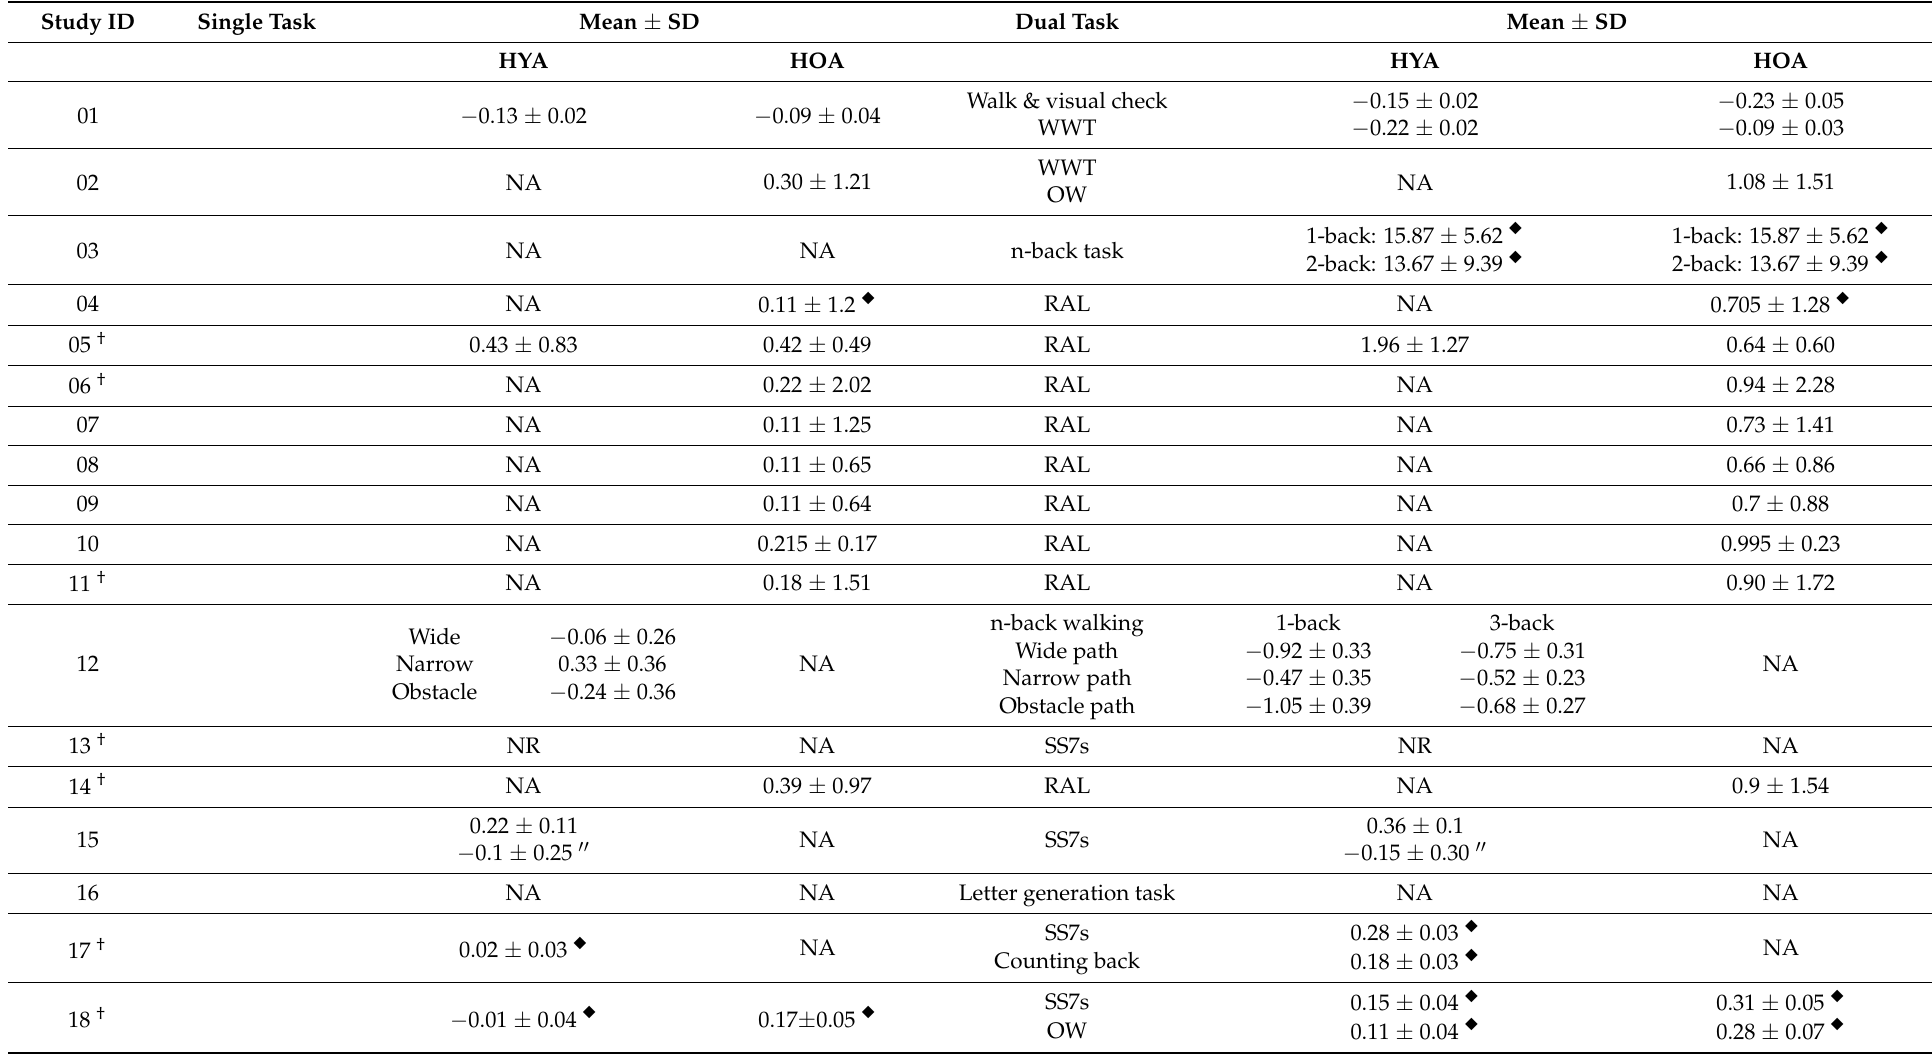
Table 2. Oxyhemoglobin (HbO 2 ) & Deoxyhemoglobin (Hb) outcome measures for studies included in the